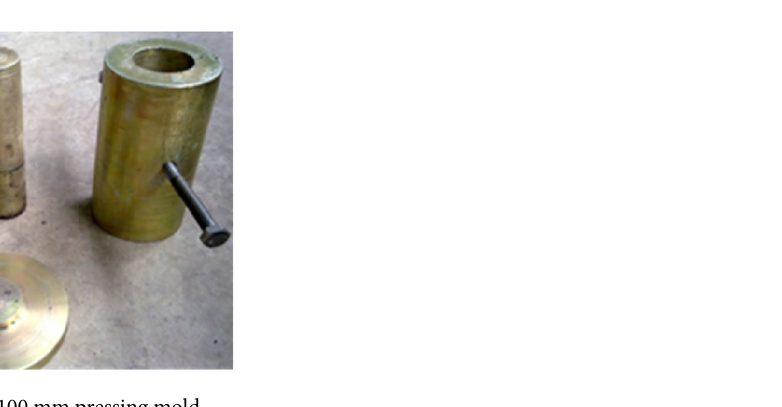
Figure 1. Rock triaxial testing machine controlled by TAW-2000 microcomputer.